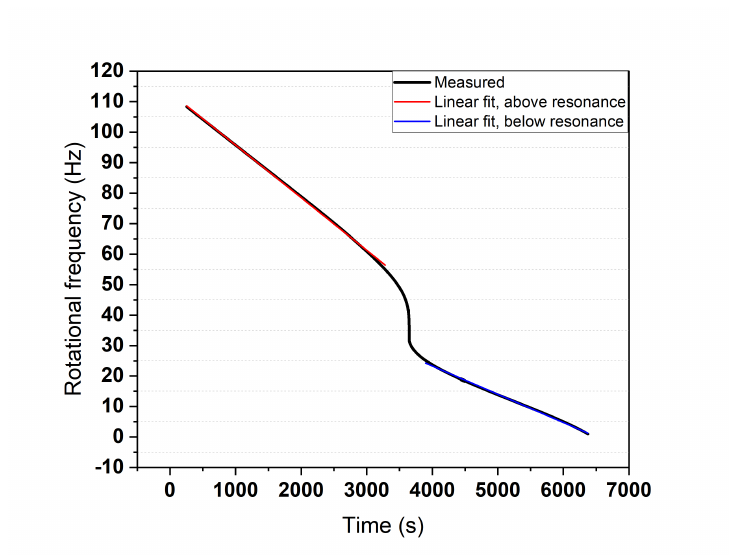
Figure 4. PM spin-down after being released at 110 Hz. From Equation (2), the COF is larger above resonance than below resonance. This can be caused by the rotation of the PM around its center of mass, which can create a radial gradient in the magnetic field over the radius of YBCO puck [5]. Figure 5 shows the vertical oscillations of the PM during the spin-down test. The oscillation amplitude grows while the PM passes through resonance, reaching a maximum of 0.5 mm.